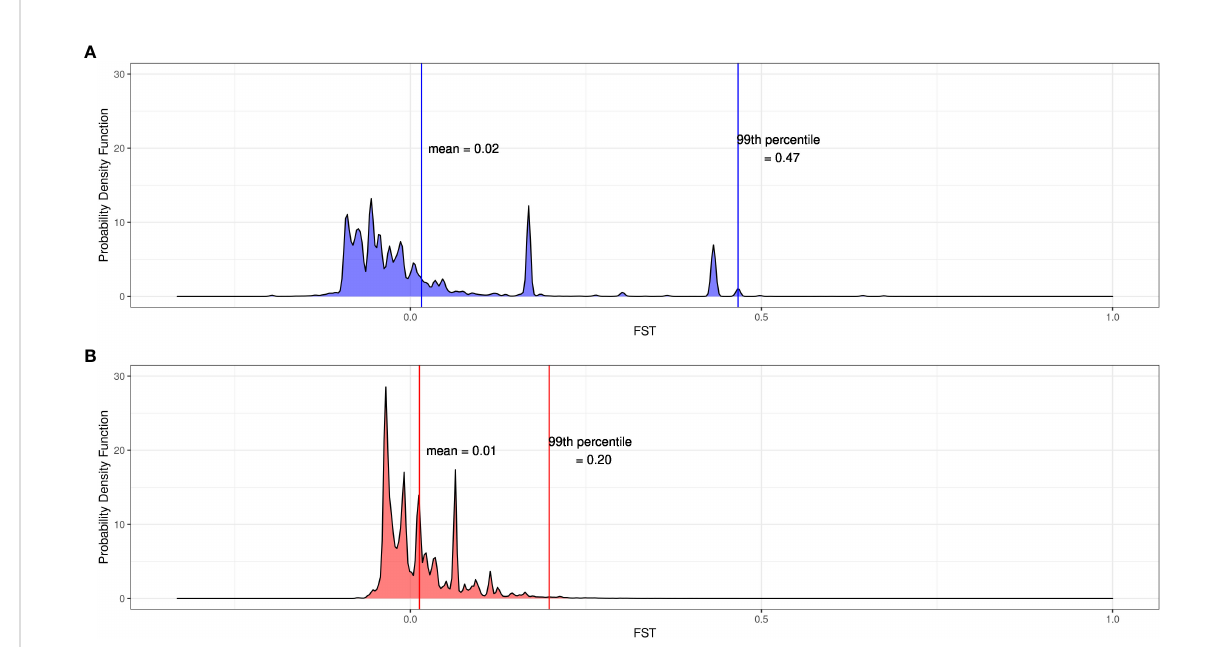
FIGURE 4 Distributions of F ST at 12.9 million SNPs between spawners and offspring for (A) the 2019 cohort and (B) the 2020 cohort. Vertical lines indicate values of the mean and the 99th percentile for each